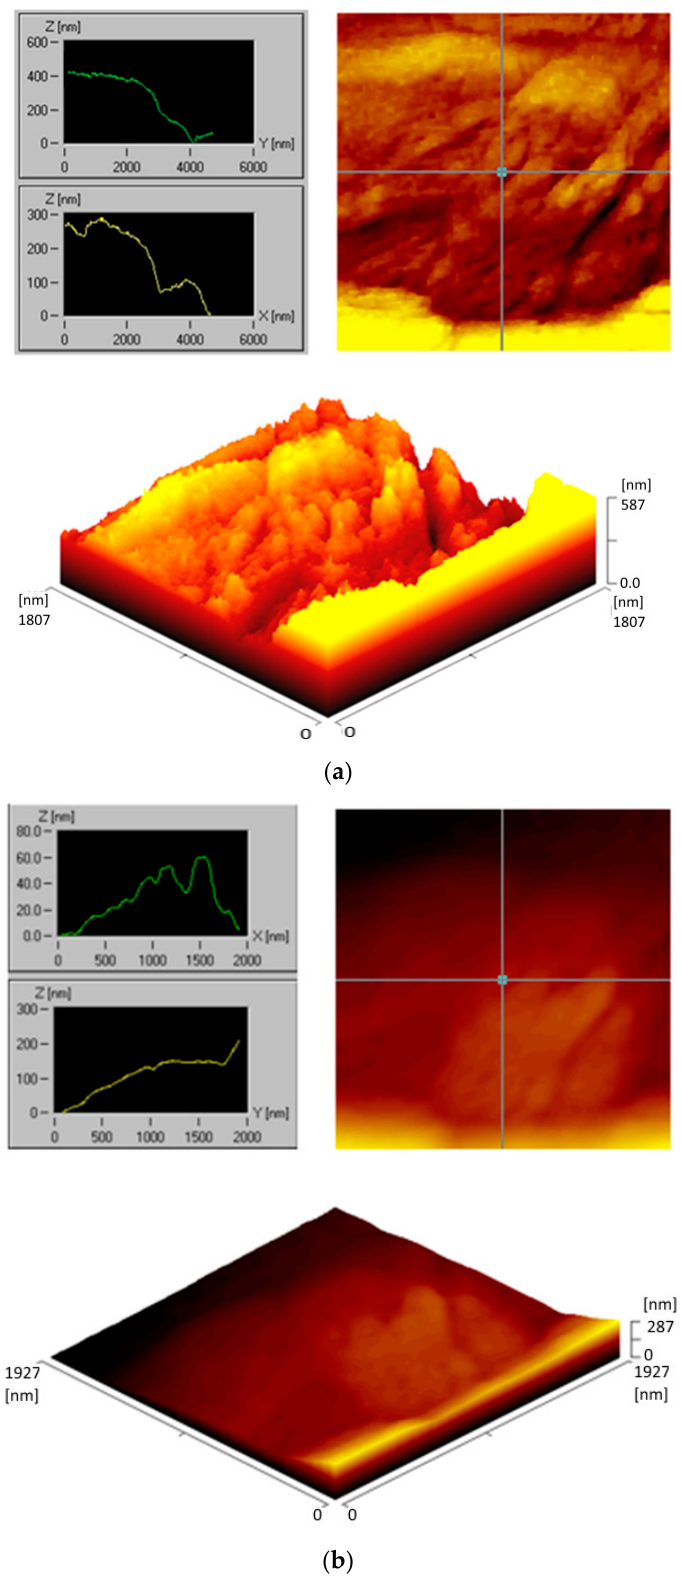
Figure 16. Ra profile on the spherical surfaces of ball joints for a Mercedes Sprinter (mileage: 80,000 km, vehicle age: 6 years): ( a ) Manufacturer ball joint, right side; ( b ) Manufacturer ball joint, left side.